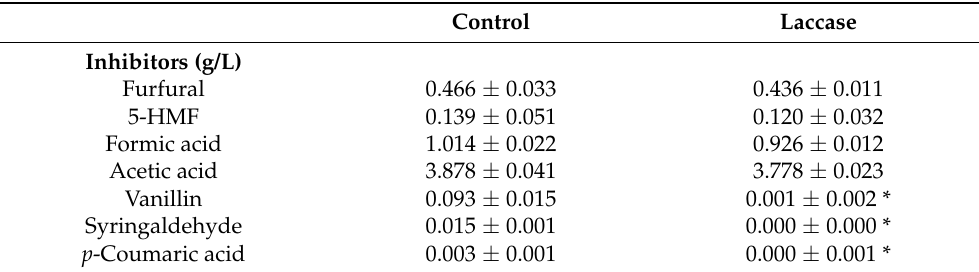
Table 2. Inhibitory compounds concentration of control and laccase-treated liquid fraction enzymatic hydrolysates. Control Laccase Inhibitors (g/L) Furfural 0.466 ± 0.033 0.436 ± 0.011 5-HMF 0.139 ± 0.051 0.120 ± 0.032 Formic acid 1.014 ± 0.022 0.926 ± 0.012 Acetic acid 3.878 ± 0.041 3.778 ± 0.023 Vanillin 0.093 ±